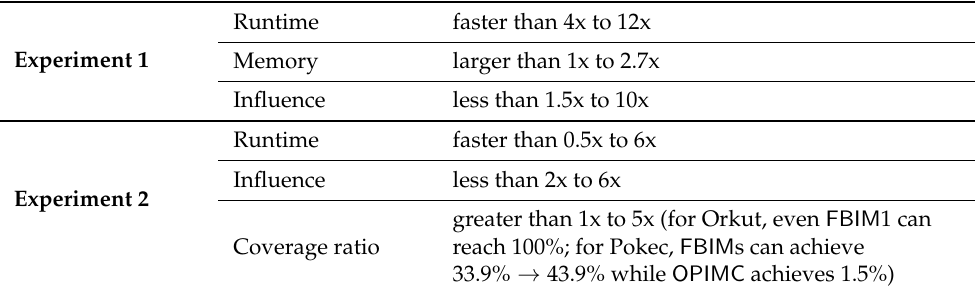
Table 3. Statistical comparison of experimental results of FBIM algorithms vs. OPIMC